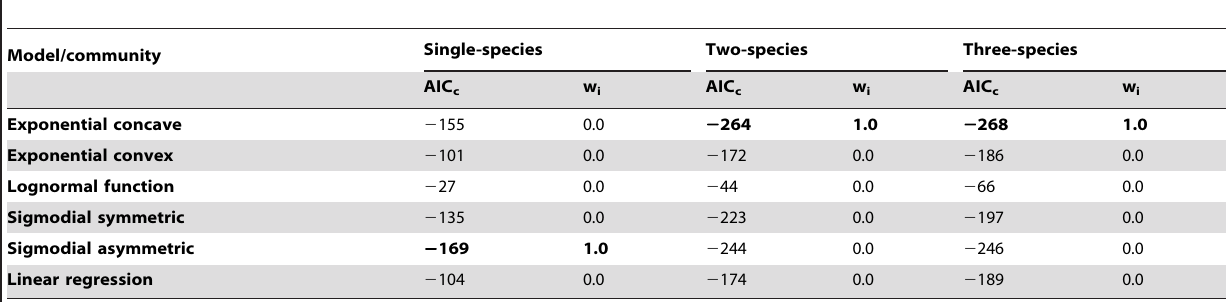
Table 3. Results summary for ranked bacterial lineage occupancy analyses for the three rodent communities.